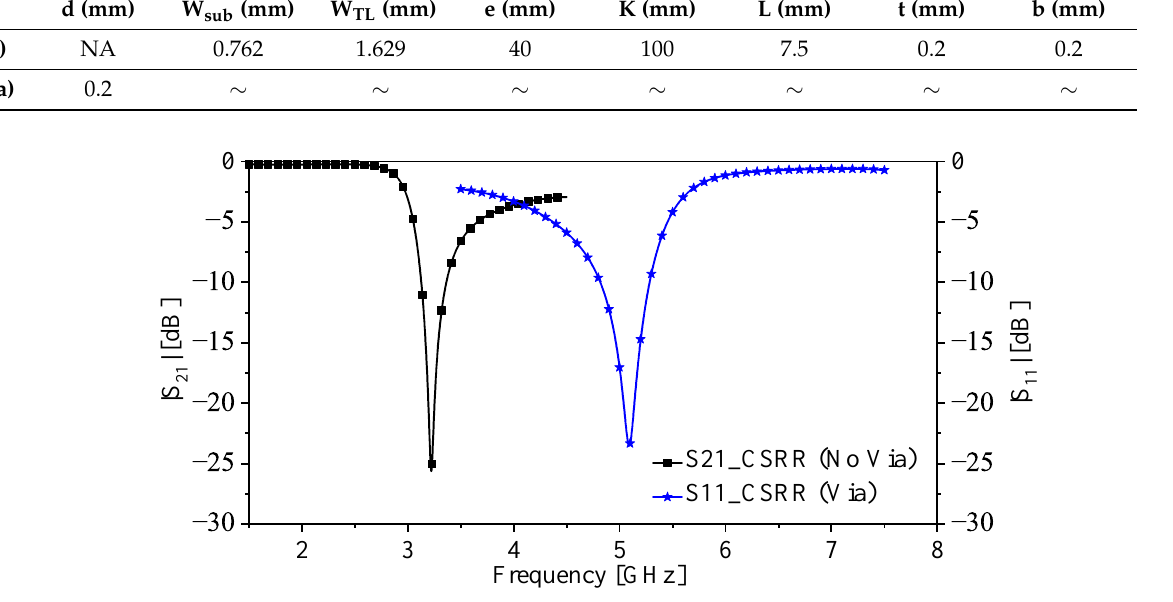
Figure 4. The responses of the original CSRR ( | S 21 | [dB]) and the proposed sensor ( | S 11 | [dB]), where the resonator’s length L = 7.5